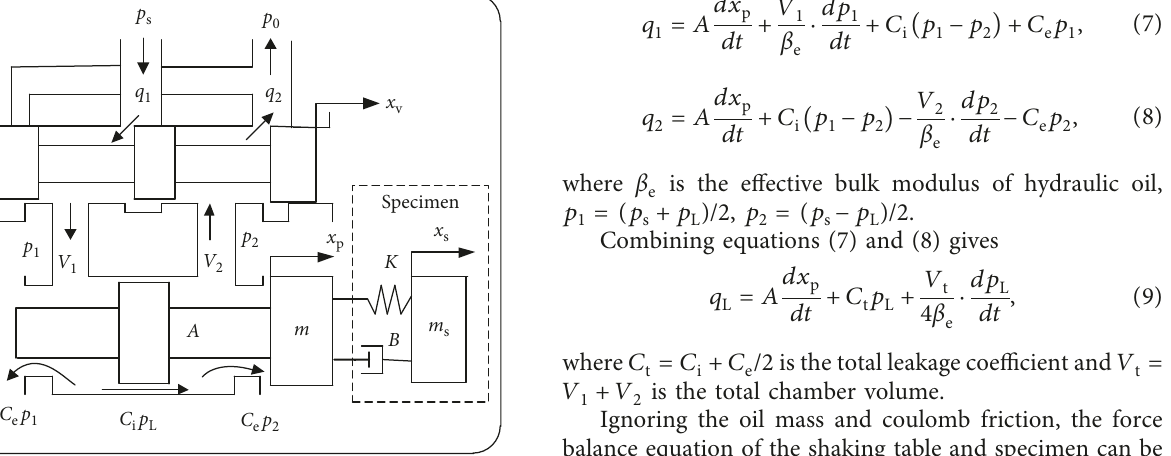
Figure 3: Schematic diagram of hydraulic actuator controlled by servo